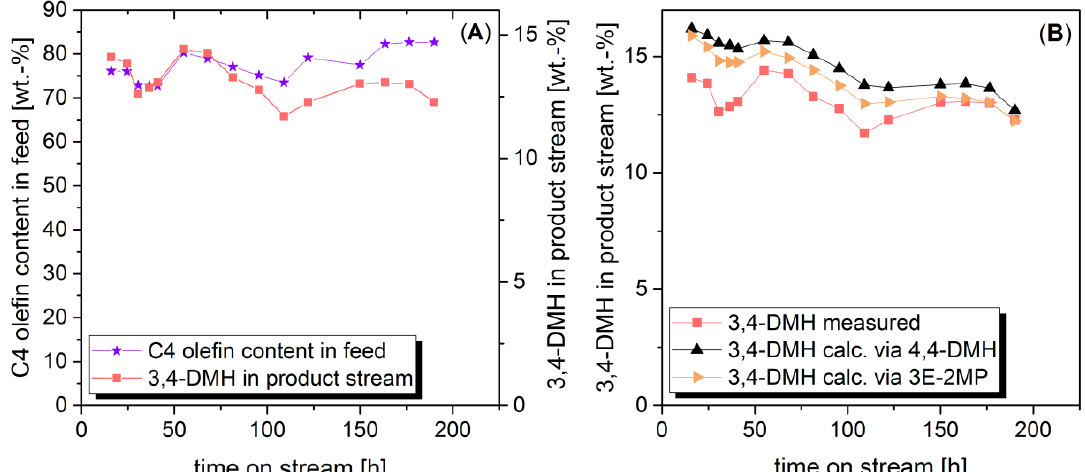
Figure 6. Catalytic results of n-butene oligomerization on the catalyst with 1 wt.% Ni at 100 °C; ( A ) 3,4-DMH in the product stream in continuous operation by varying the content of C4 olefins in the feed; ( B ) comparison between measured and calculated content of 3,4-DMH via side products in the product stream.